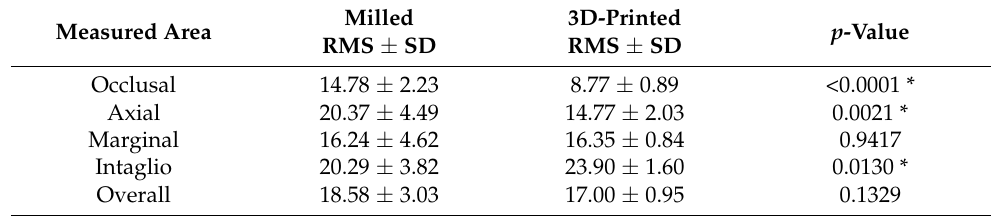
Table 3. Trueness means RMS ± SD ( µ m) and significance values between the milled and 3D-printed